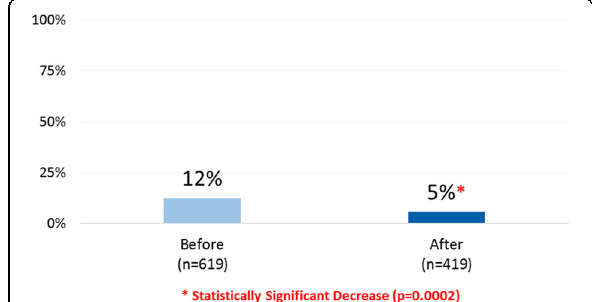
Fig. 6 Rates of perforation before and after implementation of the